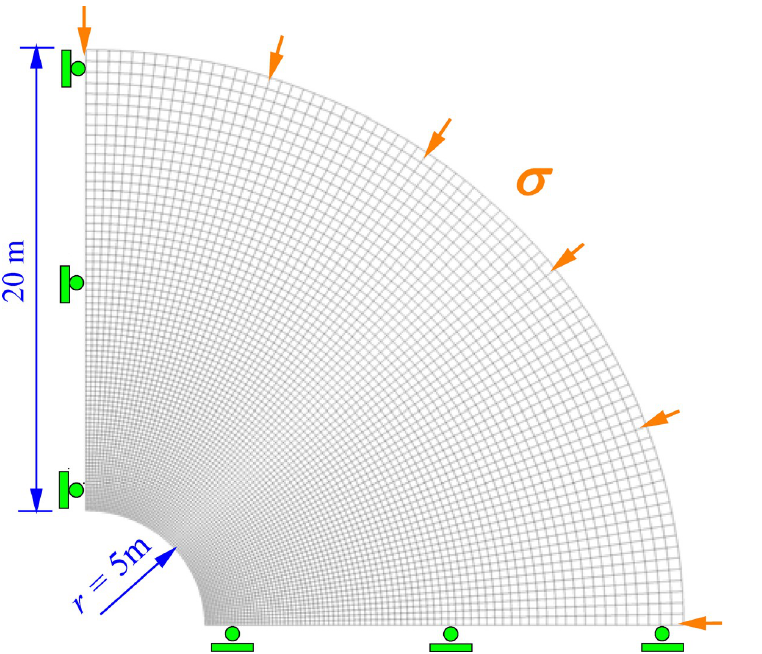
Fig 11. Dimensions and boundary conditions of the numerical